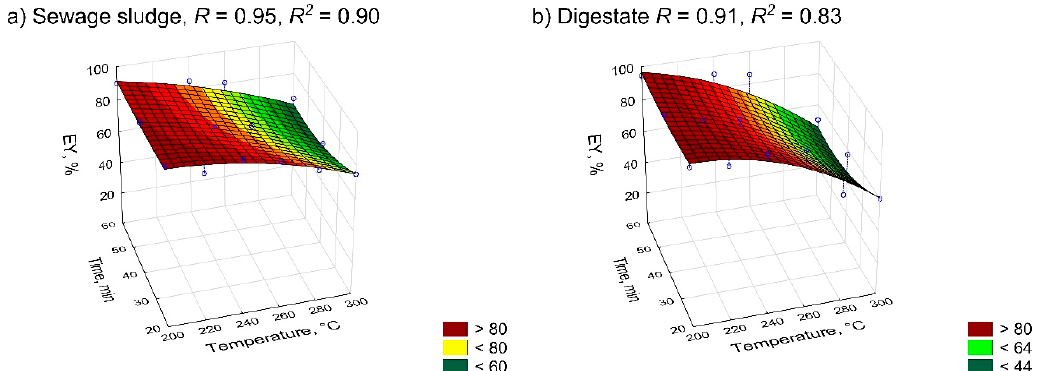
Figure 6. The influence of torrefaction temperature and residence time on the energy yield of CSF from ( a ) sewage sludge and ( b ) digestate. R —correlation coe ffi cient; R 2 —determination coe ffi